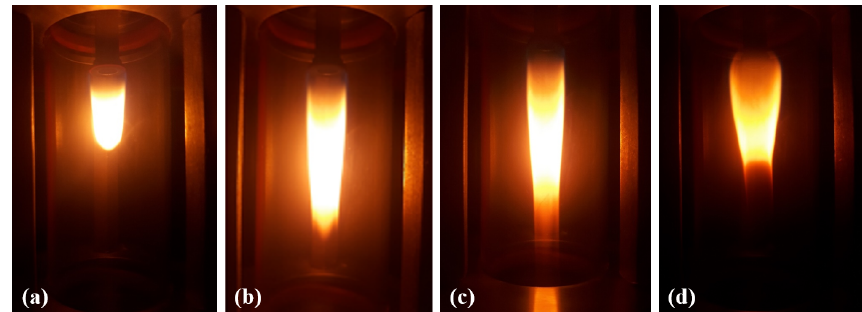
Figure 1. Examples of different flame shapes. (a) Closed tip. (b) Open tip. (c) Partially open tip. (d) Curled base flame.